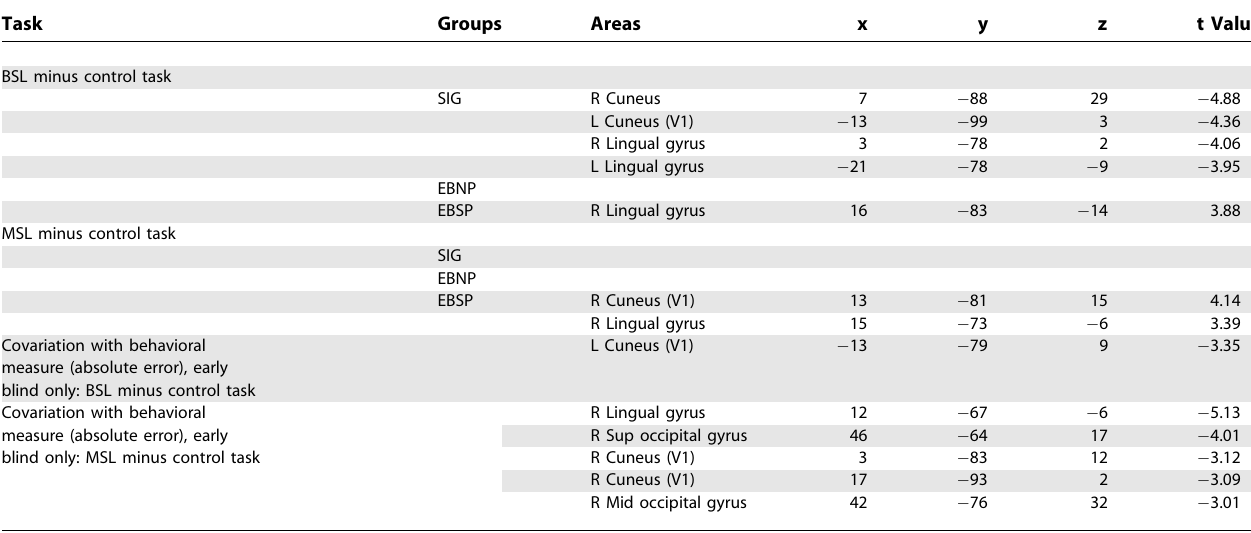
Table 1. Stereotaxic Coordinates and t Values of Activation and Deactivation Foci in Occipital Areas Task Groups